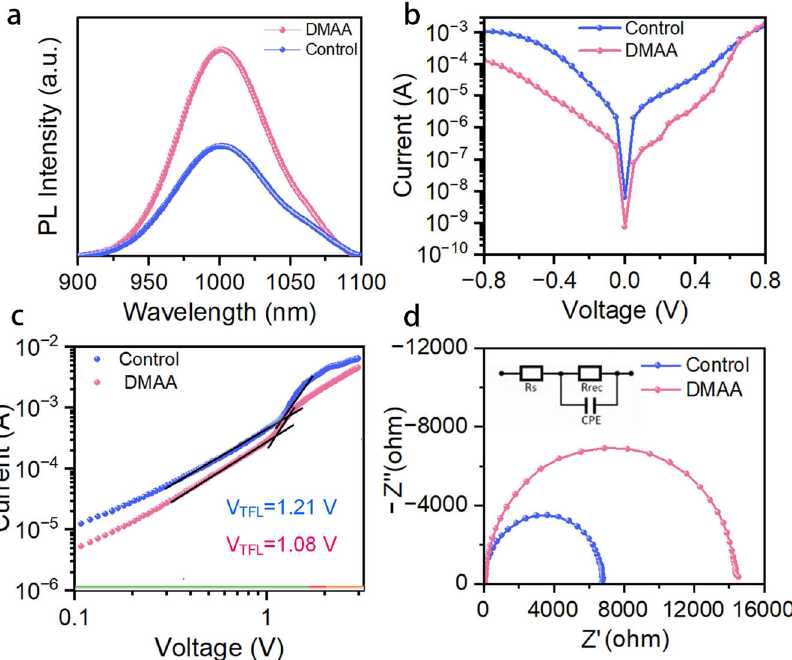
Fig. 4 Charge-carrier dynamics. a Steady-state PL spectra of perovskite fi lms. b Dark J – V curves of the PSCs. c I – V curves of the hole-only devices. d Nyquist plots of the PSCs and the inset shows the equivalent circuit diagram used for